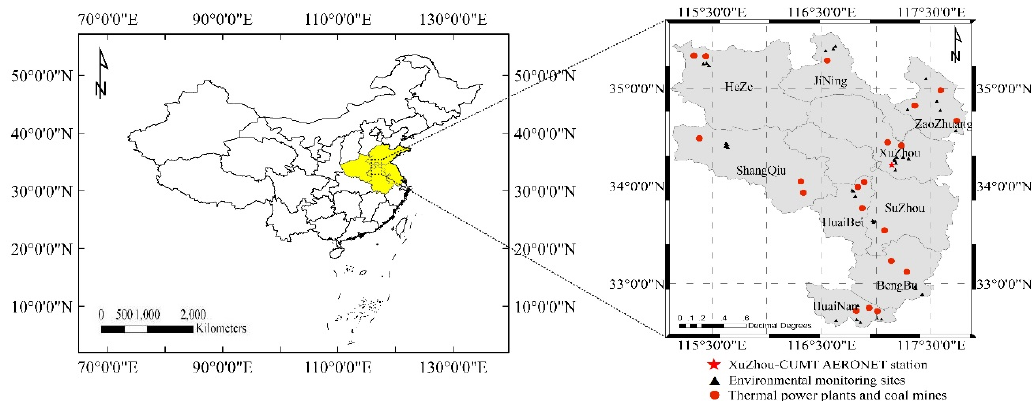
Figure 1. Location of AERONET station and environmental monitoring stations in the JSHA study region.